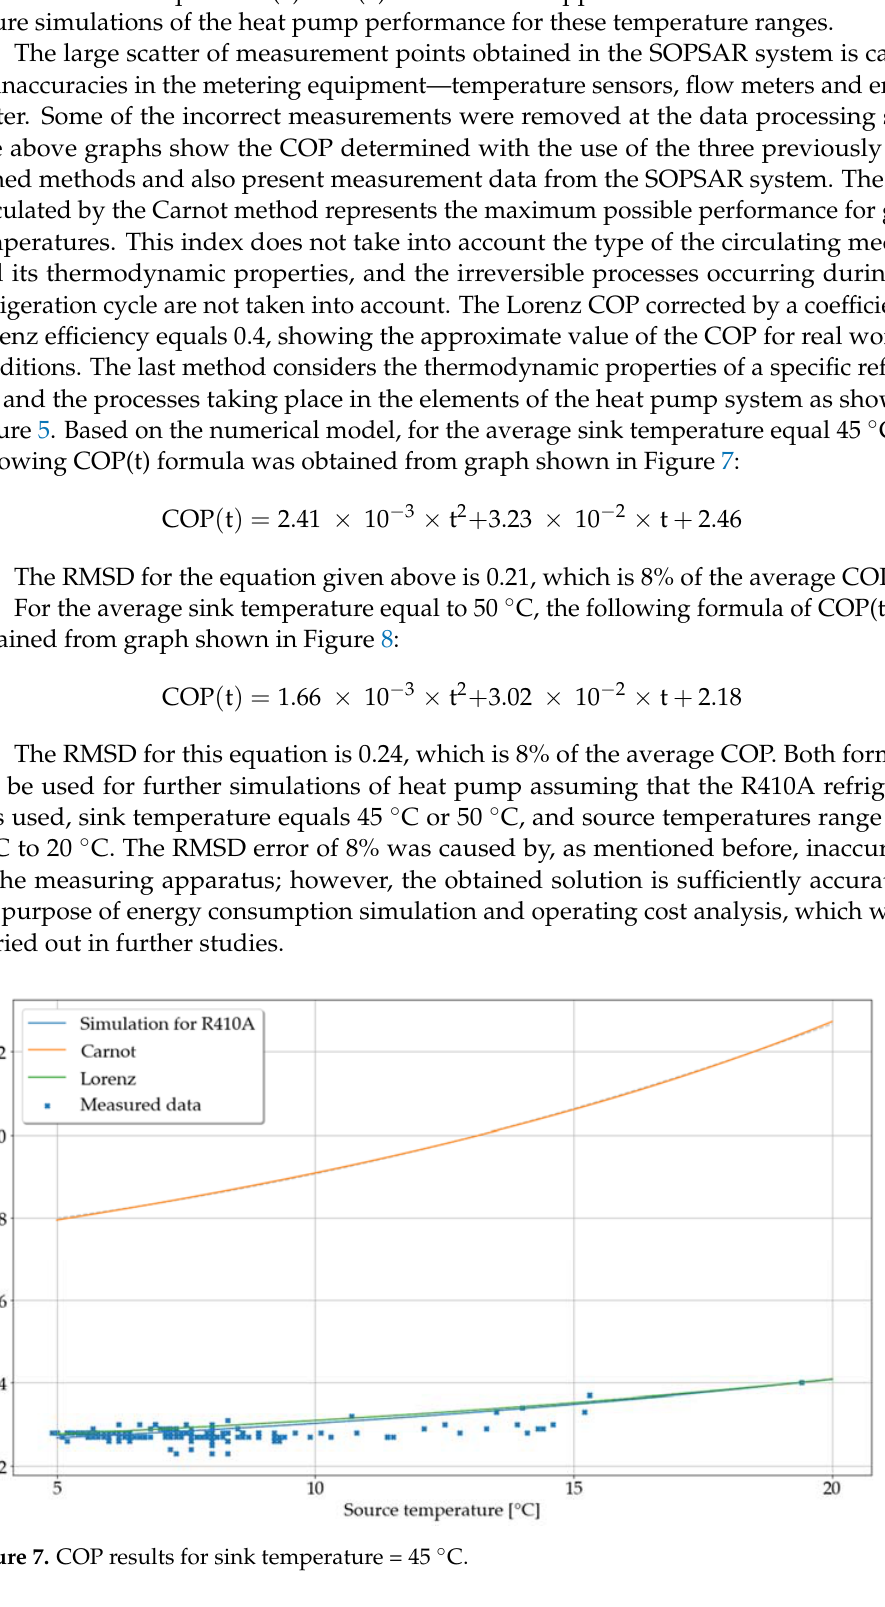
Figure 8. COP results for sink temperature = 50 °C. 4. Conclusions The method presented in this article allowed us to obtain a simple second ‐ degree linear model of COP, which can be used in further analyses. With the use of the Python numerical model presented in this article, two linear equations were developed for a specific range of heat sink and heat source temperatures and refrigerant specified in simulation. The main limitation of those equations is that they can only be used for temperatures and refrigerant for which they were specified. Using the Python numerical script, you can prepare linear equations for other refrigerants and other temperature ranges. In the simulation, it was determined that the COP for the sink temperature of 45 °C and source temperature of 5 °C is equal to 2.7. For the same sink temperature and source temperature of 15 °C, COP is equal to 3.5. For sink temperature of 50 °C and source temperature of 5 °C, the COP equals 2.4 and 3.0 for source temperature of 15 °C. Both